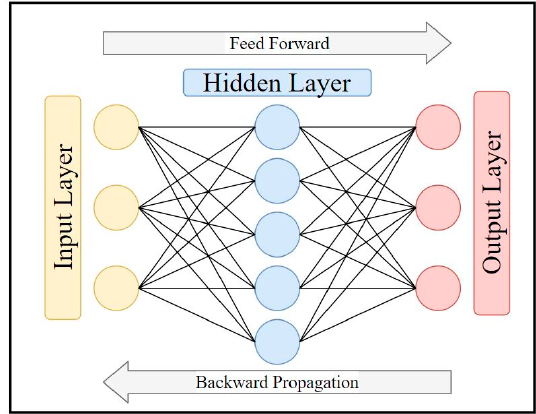
Figure 3. Basic schematic of ANNs [81].